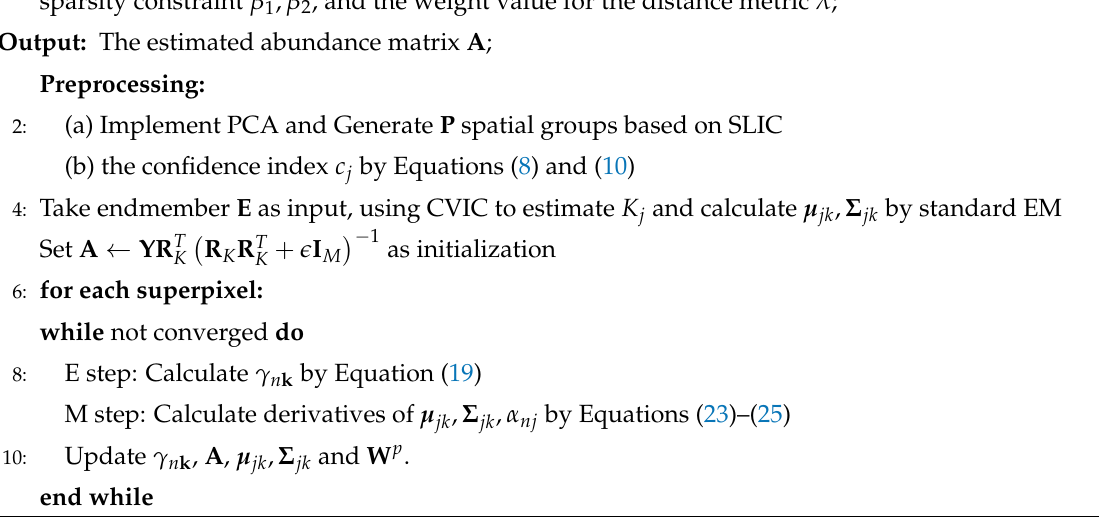
Algorithm 2 Details for supervised of